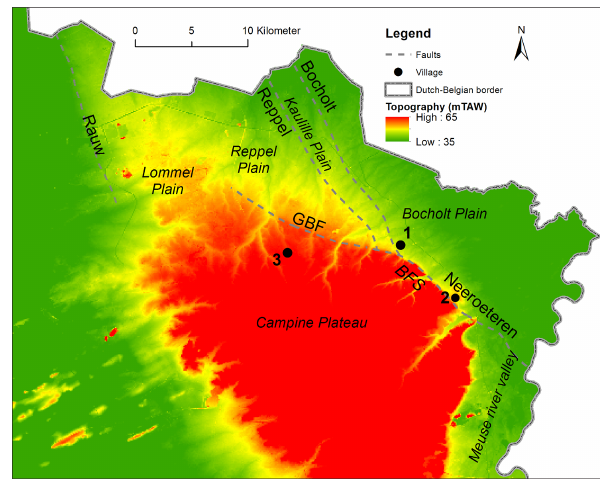
Figure 4. Topography in the study area with indication of the main morphological features and faults of the G3Dv3 model that have a topographic expression. BFS: Bree Fault scarp; GBF: Grote Brogel fault; numbers denote villages: 1 – Bree; 2 – Waterloos; 3 – Peer. DTMV-II model from Agentschap Informatie Vlaanderen